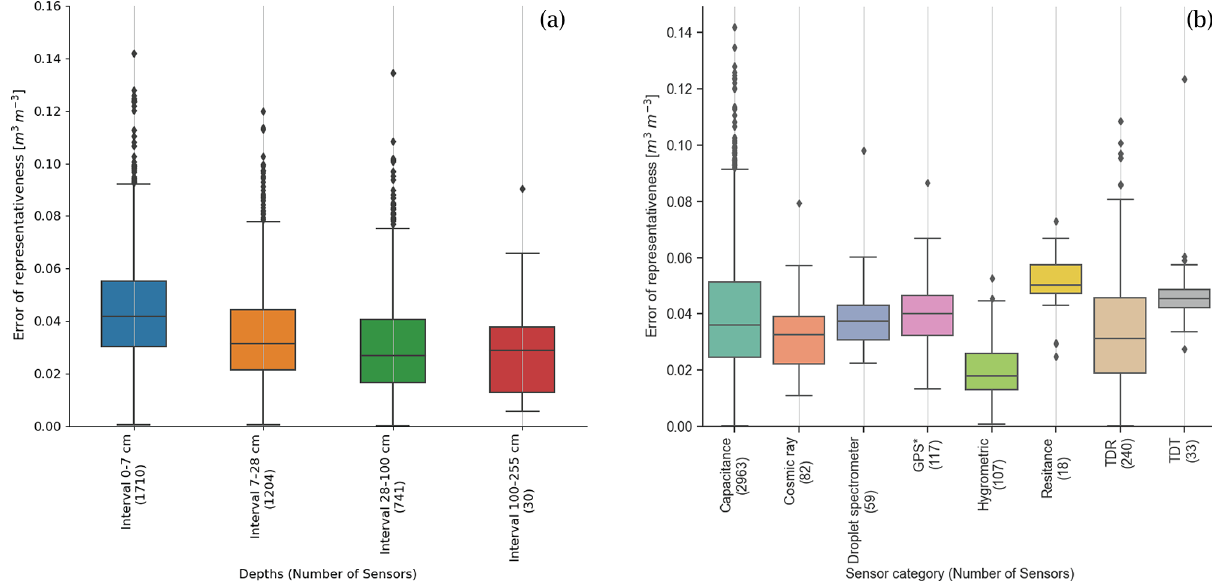
Figure 8. Representativeness errors for different sensor depths (a) and sensor types (b) derived with triple collocation. Summary of triple collocation characterisation of random errors per sensor type. Values in parentheses show the total number of sensors for each depth interval and type,